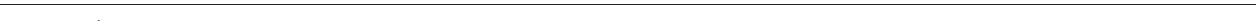
FIGURE 1 | ROI alignment, segmentation, % change map, grid preparation for quantification, and final averaged heat map (right). (B) Heat maps of cerebral perfusion (CBF) in individual mice of different ages following whisker stimulation. Each perfusion map was created by averaging LSCI values from three whisker stimulations. Mean depicts the average of all animals in one group. The dark blue color indicates no or small changes in cortical perfusion, while the yellow color indicates increases of cortical perfusion of up to 15%. (C) Quantification of maximal CBF changes. Young and 1-year-old mice had significantly higher NVC responses in comparison to 2 years old mice (* P < 0.05: 6–8 weeks vs. 2 years old, *** P < 0.001: 1 year vs. 2 year, One-way ANOVA). (D) Quantification of the velocity of CBF increase after whisker stimulation by slope analysis. Two year old mice had a significantly slower CBF increase in comparison to young and 1 year old mice (* P < 0.05: 6–8 weeks vs. 2 year and 1 year vs. 2 year) ( n = 6–10 mice/group, mean ± SEM, One-way